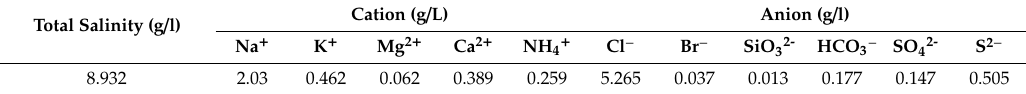
Table 1. Composition of formation water.